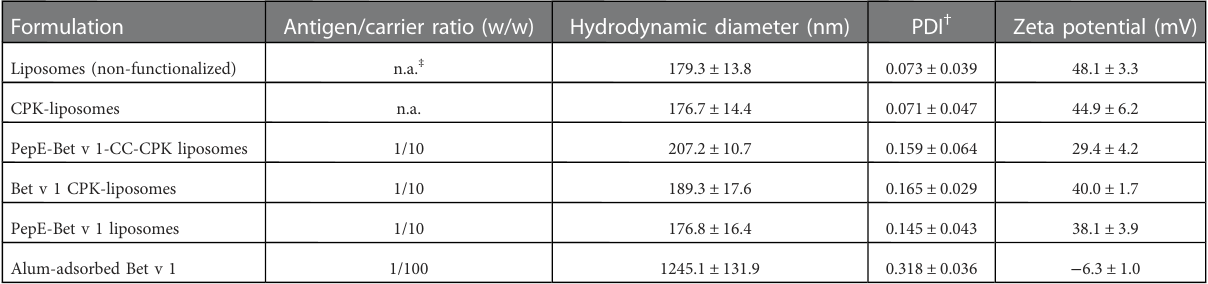
TABLE 1 Overview of all formulations and their physicochemical characteristics (mean values±SD, n =3-5). All formulations contained the same buffer composed of 10 mmol/L HEPES, 280 mmol/L sucrose, pH 7.4.